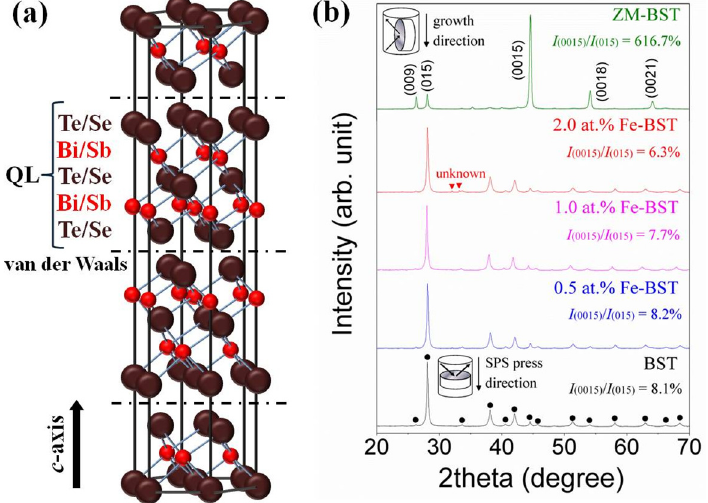
Figure 1. ( a ) Crystal structure of Bi 2 Te 3 -based thermoelectric materials; ( b ) X-ray diffraction (XRD) patterns of the zone-melted ingot of Bi 0.48 Sb 1.52 Te 3 (ZM-BST) sample in the plane parallel to the growth direction and for BST and Fe-BST samples in the planes perpendicular to the spark plasma sintering (SPS) press